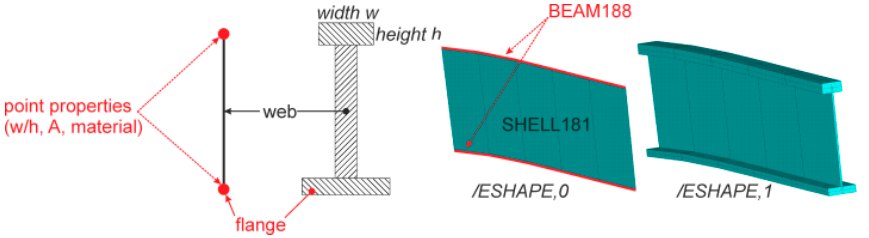
Figure 18. Mixed frame discretization.